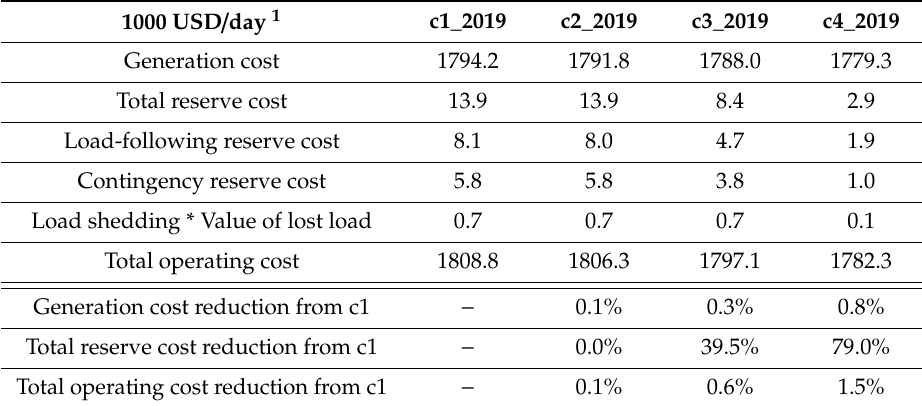
Table 5. Daily operating costs of generation and reserve for a summer peak day in